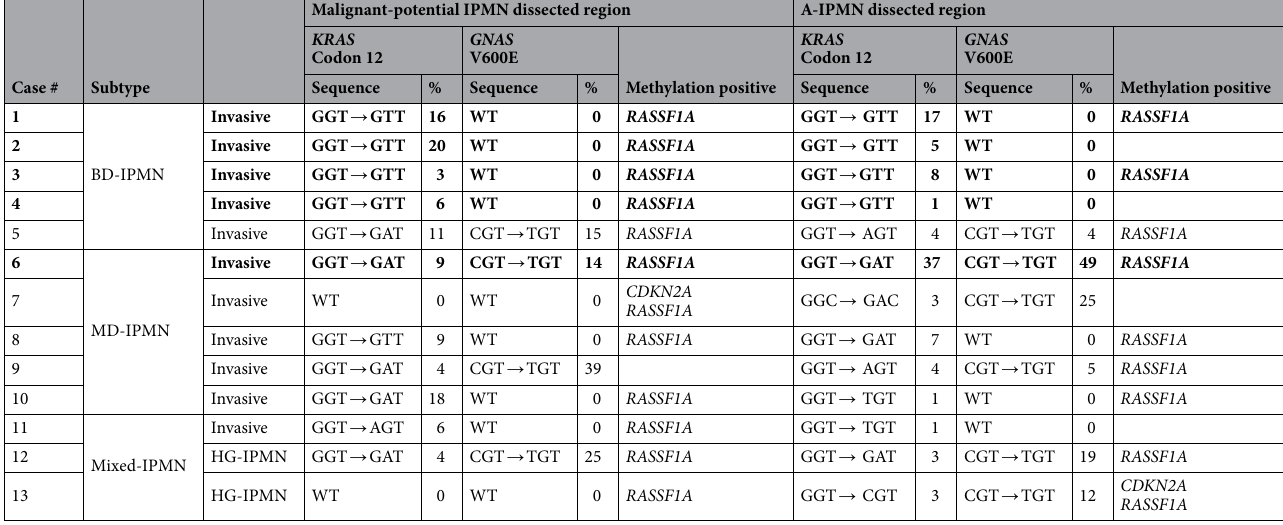
Table 3. Patterns of methylation and mutation results for malignant-potential IPMN and A-IPMN dissected regions accompanied by malignant-potential IPMN dissected regions. Cases with bold letters have concordant KRAS and GNAS sequences between malignant-potential IPMN and A-IPMN dissected regions. WT, wild